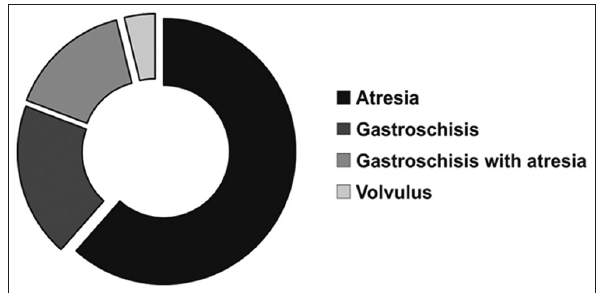
Figure 2: Primary diagnosis in “first STEP” cases